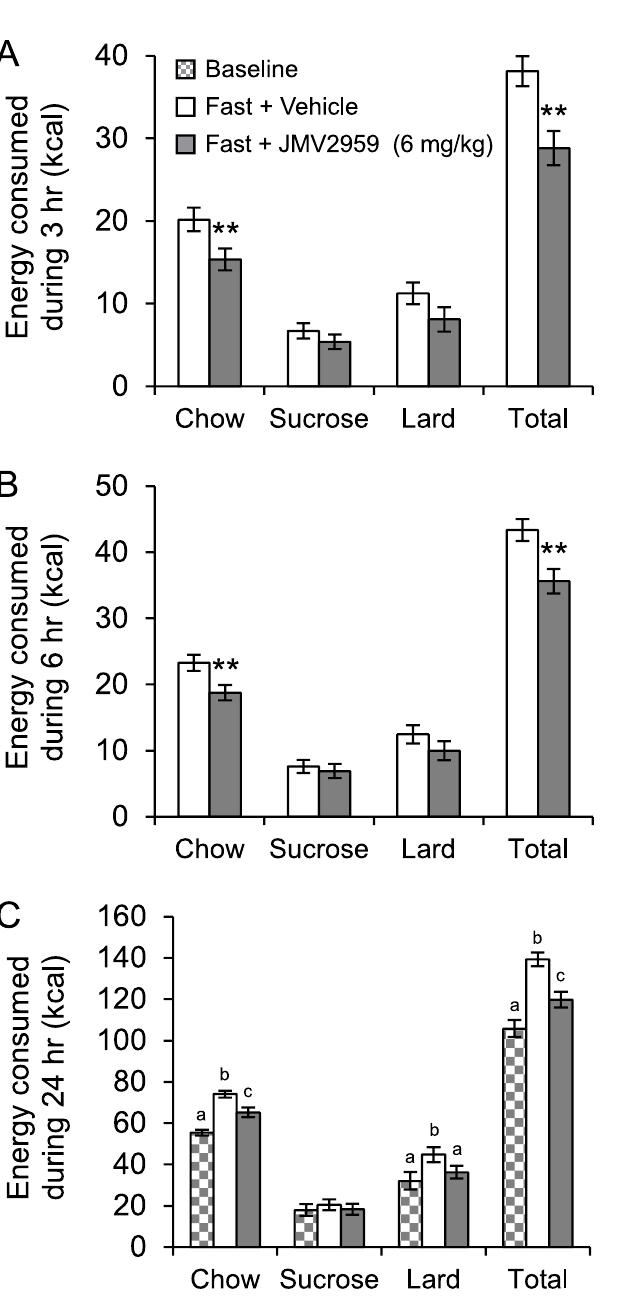
Fig 4. Impact of fasting and peripherally administered ghrelin receptor antagonist on dietary choice. Impact of acute intraperitoneal injection of a ghrelin receptor antagonist on fasting-induced changes in total energy intake and dietary choice measured during (A) 3 hr, (B) 6 hr and (C) 24 hr after the end of an overnight fast, in rats (n = 24) that had been ad libitum fed a choice diet comprising normal chow, 1 g sucrose pellets and lard (saturated animal fat) for 14 days prior to fast. All rats received the antagonist and saline solution in a cross over design with one day washout between injections. In panels A and B; ** P < 0.01. In panel C, the letters indicate significant differences (rANOVA, P <